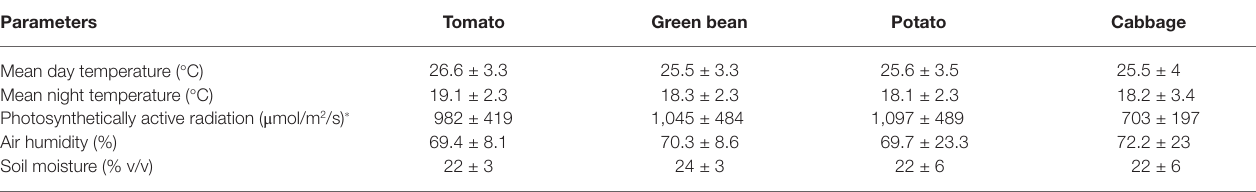
TABLE 3 | Greenhouse parameters during the growing period.